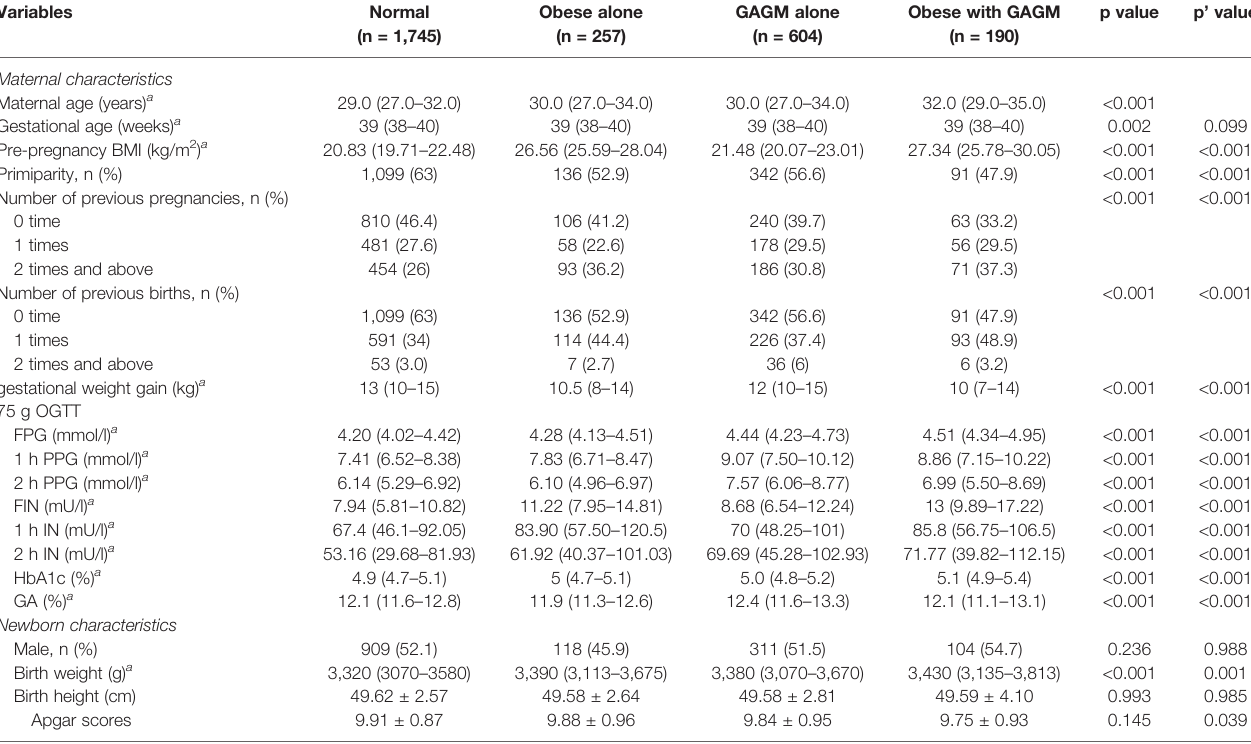
TABLE 1 | Characteristics of pregnant women and their neonates according to maternal pre-pregnancy obesity and GAGM. Variables Normal